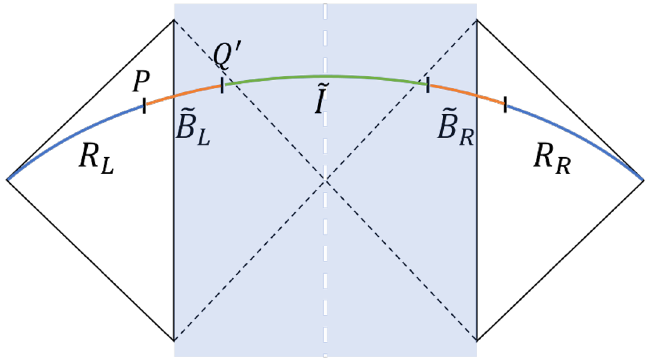
Figure 17 . Radiation and black hole on one side and the reflection on the other side. The ( σ, t ) coordinates are P : ( b, − t + πi ) , Q 0 : ( − a, − t + πi )